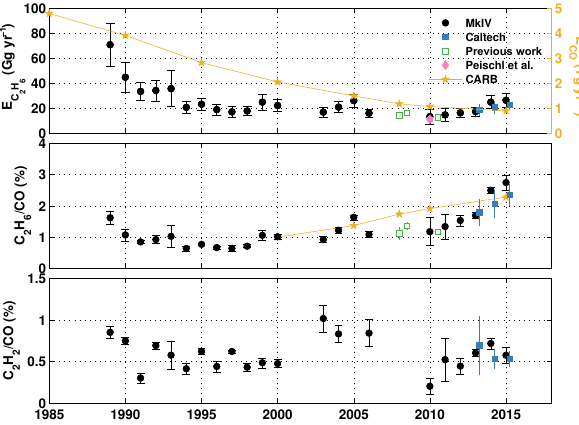
Figure 3. The top panel right axis shows the estimated carbon monoxide emissions inventory for the SoCAB, published by the California Air Resources Board (CARB). The top panel left axis shows the inferred emissions of ethane from the MkIV FTS (black circles), the Caltech FTS (blue squares), previous estimates from Wennberg et al. (2012) and Hsu et al. (2010) (green squares), and Peischl et al. (2013) (pink diamond). The second panel shows the ethane to carbon monoxide anomaly slopes from the MkIV FTS (black circles), the Caltech FTS (blue squares), and previous stud- ies (green squares). The gold line with gold stars represents what the ethane to carbon monoxide anomaly slope would be if ethane in the atmosphere remained constant at 1% of the year 2000 carbon monoxide emissions from 2000 onward. The third panel shows the acetylene to carbon monoxide anomaly slopes, which are reason- ably invariant over the time series.